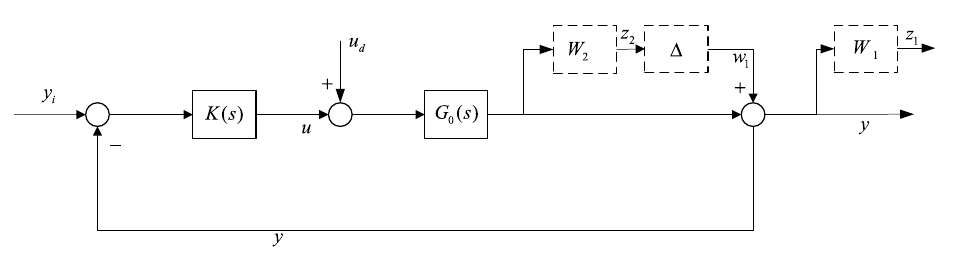
Figure 6. Block diagram of the control structure of